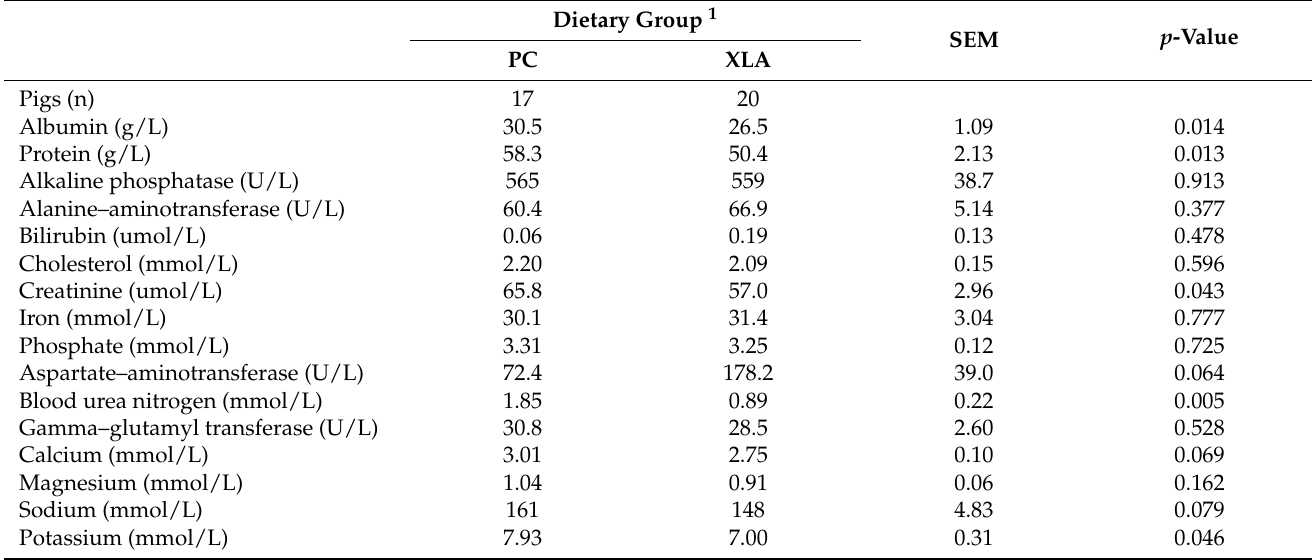
Table 5. Biochemical blood parameters analysis of the PC and XLA pigs at 24 days post-weaning.